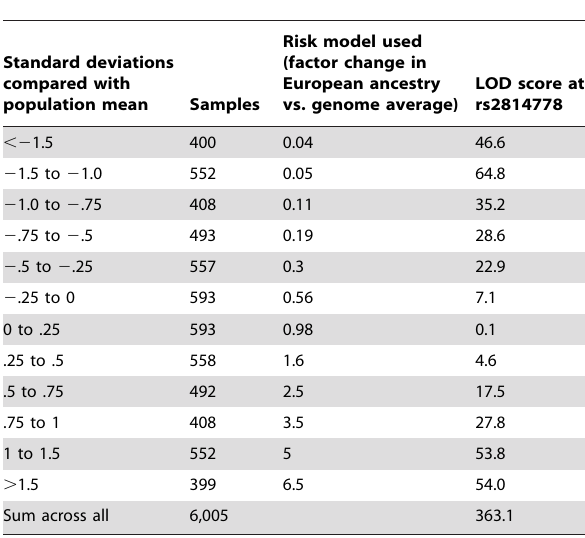
Table 3. Stratification of samples into 12 groups for admixture mapping analysis.